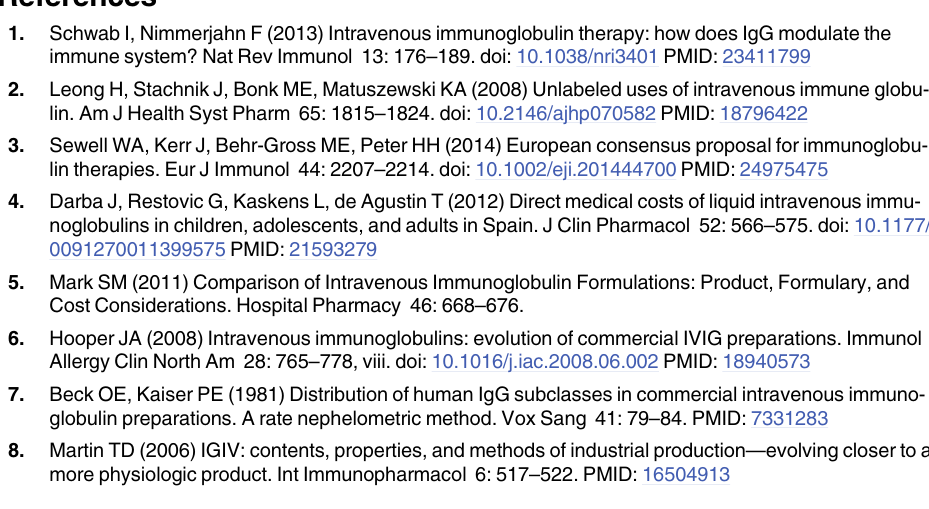
S1 Fig. IgG Fc-glycosylation of IVIg preparations available of IgG2/3. Comparable to Fig 1,